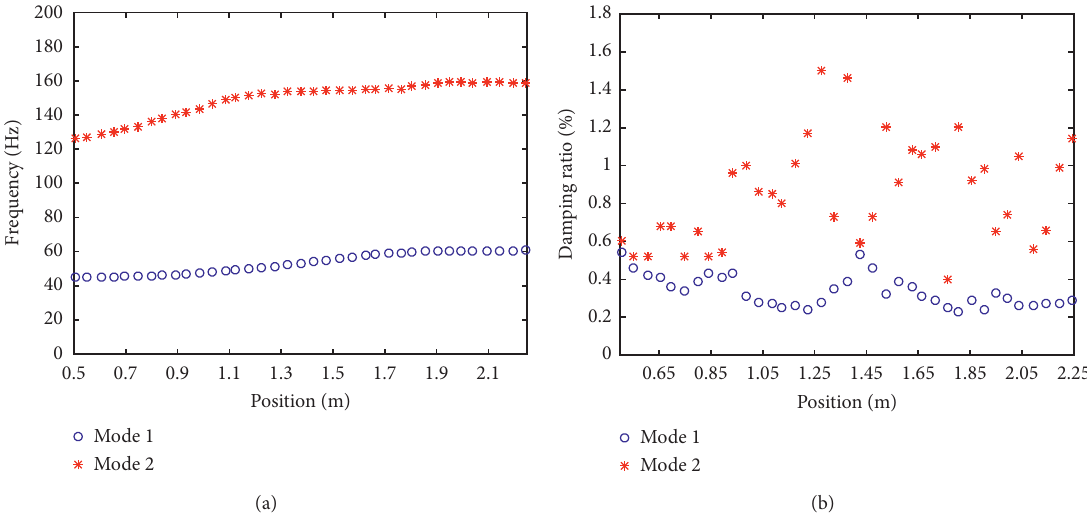
Figure 2: Modal parameters varying with the water level position: (a) natural frequencies and (b) damping ratios.